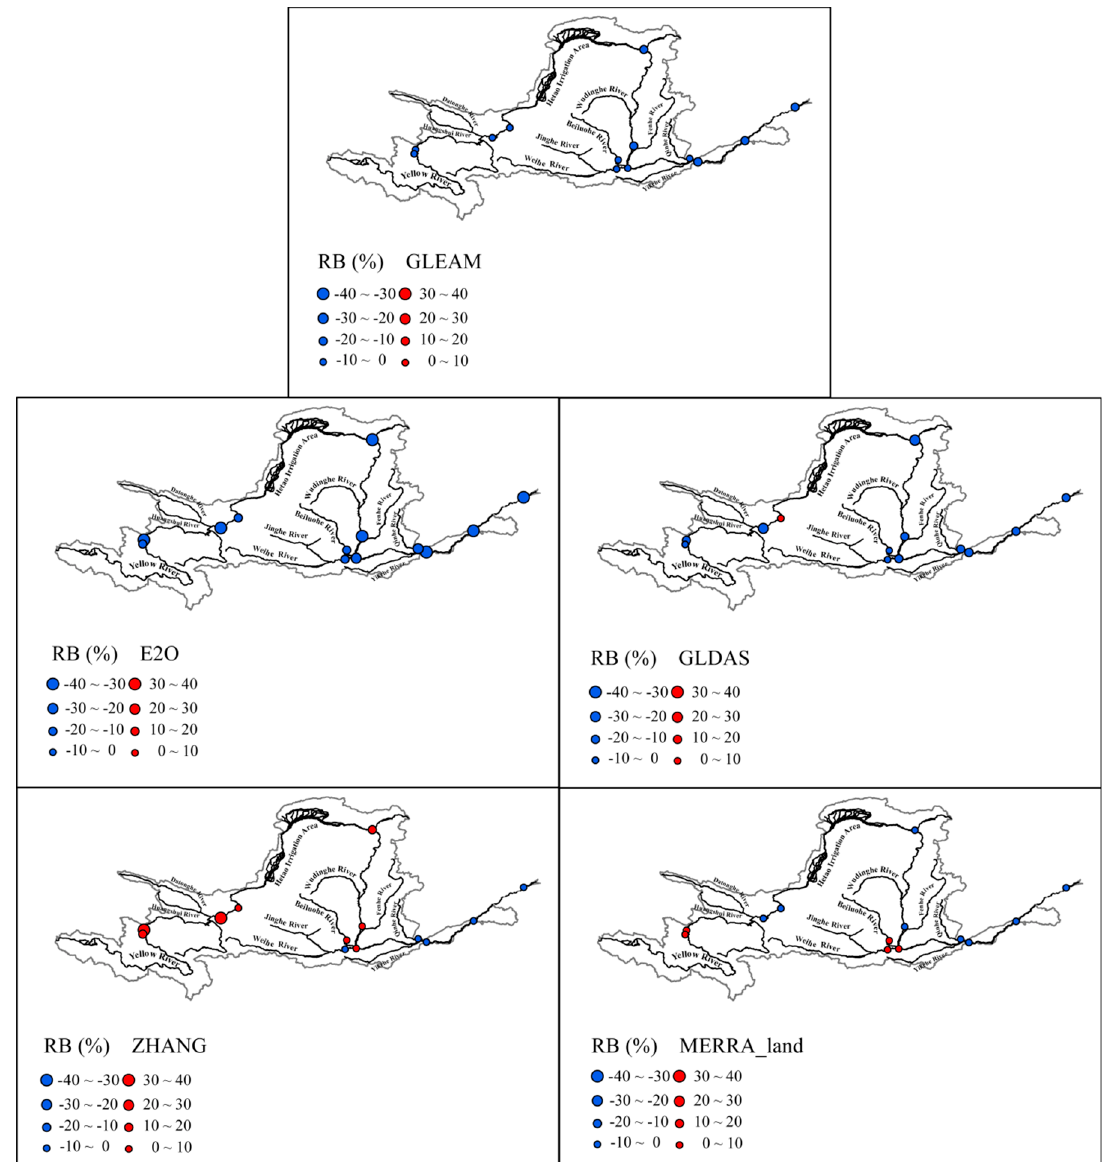
Figure 3. Spatial distribution of the relative bias (RB) parameter (%) between multi-year average evapotranspiration (ET) estimated from different products and from water balance ET (ET w ).